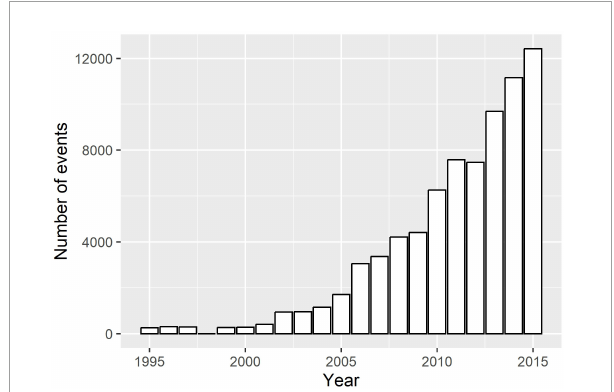
FIGURE4 Number of severe convective storms (tornado, watersprout, severe wind, flash-flood and hail) reports in ESWD from 1995 to 2015 (adapted from Groenemeijer et al.,